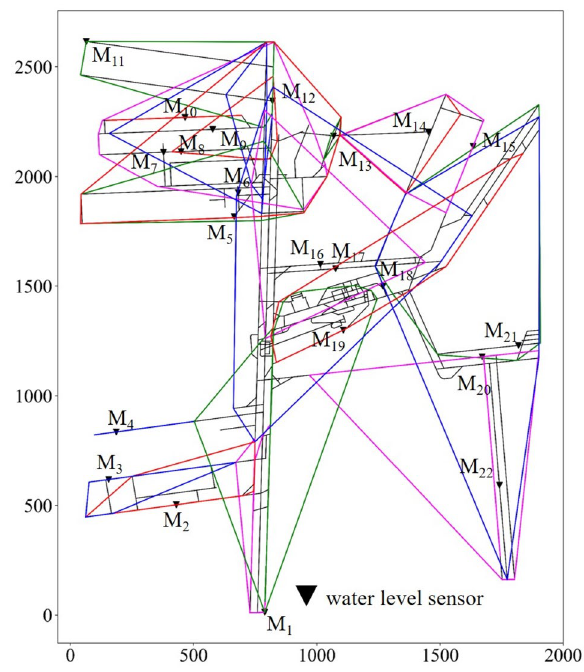
Figure 15. Reliability verification of the monitoring scope of the located water level